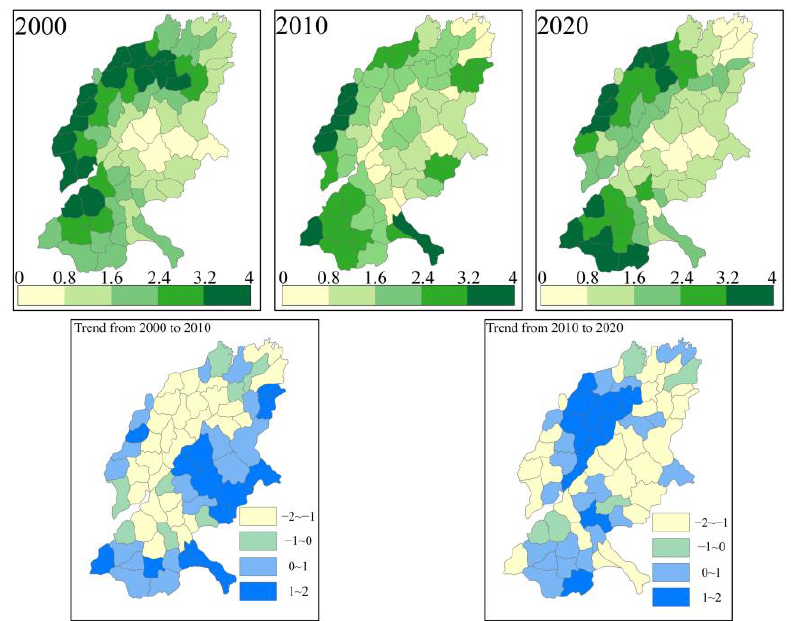
Figure 6. First-row diagram: Spatial distribution of the overall sum of the intensity of different ecosystem service trade-offs in SYRB; Second-row diagram: Trends of the overall sum of the intensity of different ecosystem service trade-offs in different counties in SYRB.